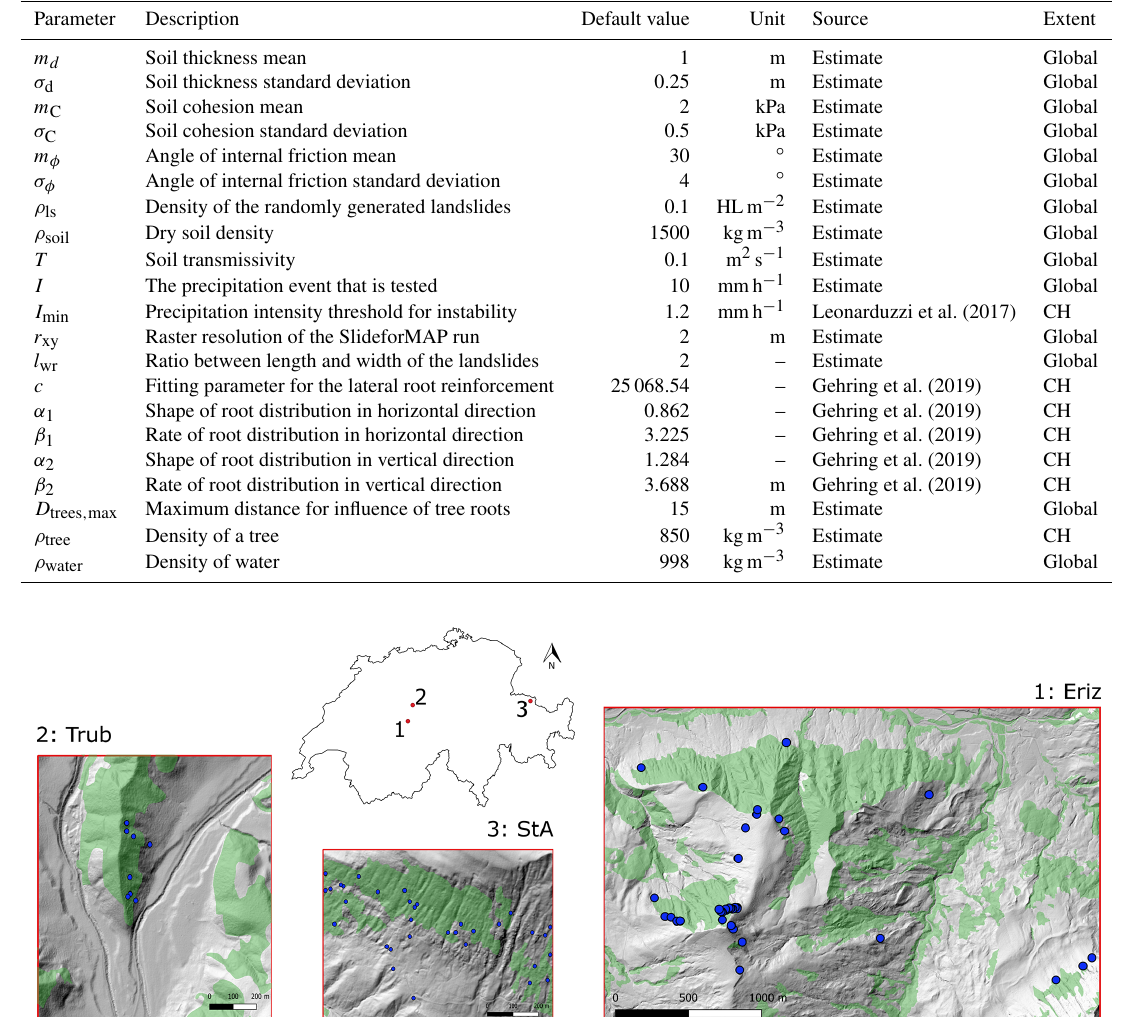
Table 1. An overview of all variable model parameters of SlideforMAP. The second-to-last column indicates the source of the default value. The last column indicates whether the default is global or specific for this research in Switzerland (CH).